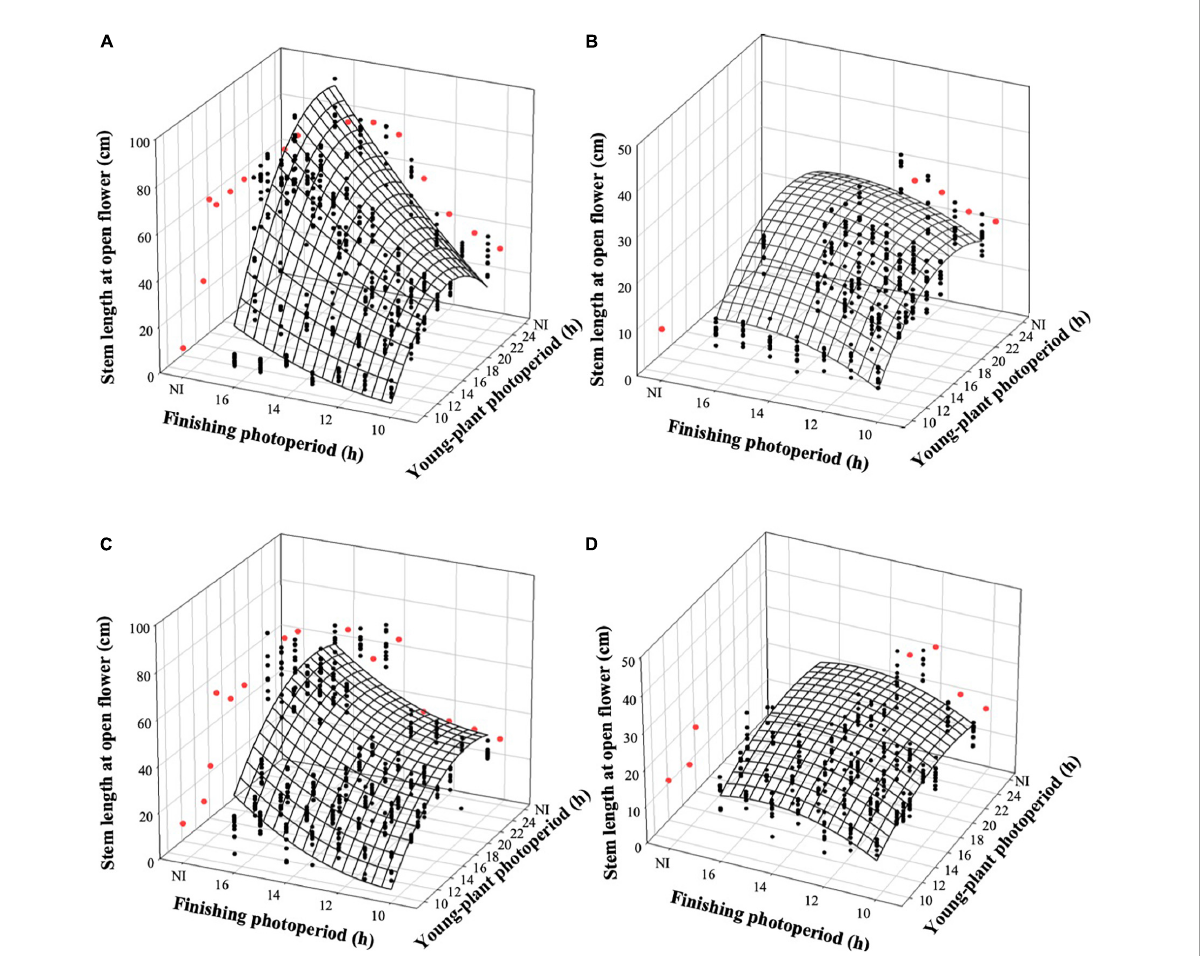
FIGURE5 Effects of young-plant photoperiod [9, 12, 13, 14, 16, 18, and 24 h, or a 4-h night interruption (NI)] and finishing photoperiod (10, 11, 12, 13, 14, 15, and 16 h, or a 4-h NI) on stem length of witchgrass ‘Frosted Explosion’ ( Panicum capillare ) at the open flower. Figures represent (A) moderate-DLI-grown ( ≈ 10 mol · m - 2 · d - 1 ) cut flowers from replication 1, (B) very-low-DLI-grown ( ≈ 3 mol · m - 2 · d - 1 ) cut flowers from replication 1, (C) moderate-DLI-grown cut flowers from replication 2, and (D) very-low-DLI-grown cut flowers from replication 2. Black circles represent individual data points for sequential photoperiods; red circles represent averages from NI treatments. Model predictions are represented by response surfaces; coefficients are presented in Table 8